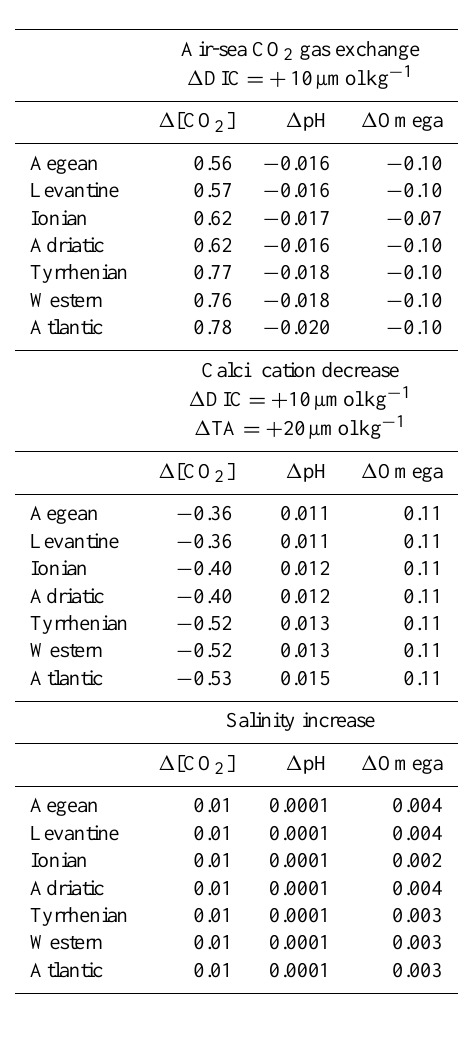
aragonite saturation state due several partial pressure of CO 2 in the atmosphere increase. The initial conditions are the mean 2011 val- ues (Table 2).